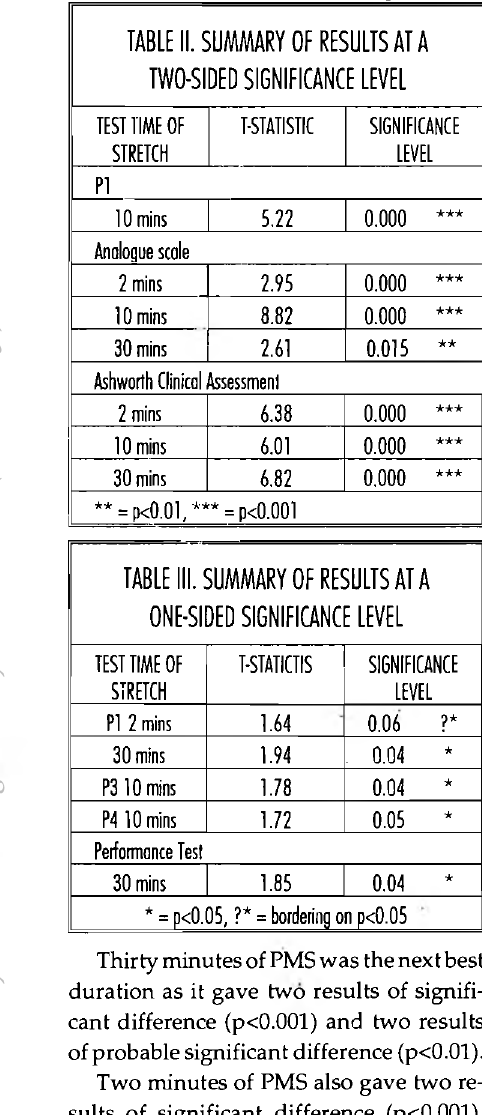
TABLE III. SUMMARY OF RESULTS AT A ONE-SIDED SIGNIFICANCE